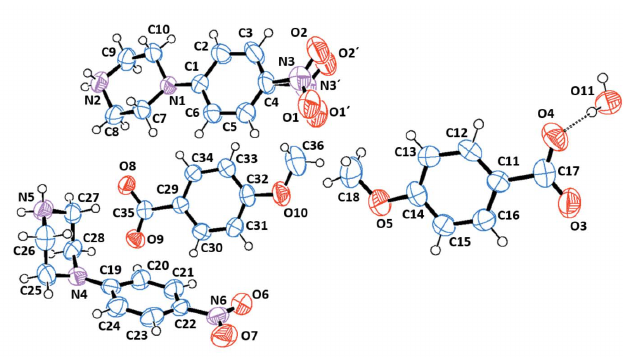
Figure 5 The independent components of compound (V) showing the atom- labelling scheme and the hydrogen bonds, drawn as dashed lines. Displacement ellipsoids are drawn at the 50% probability level.